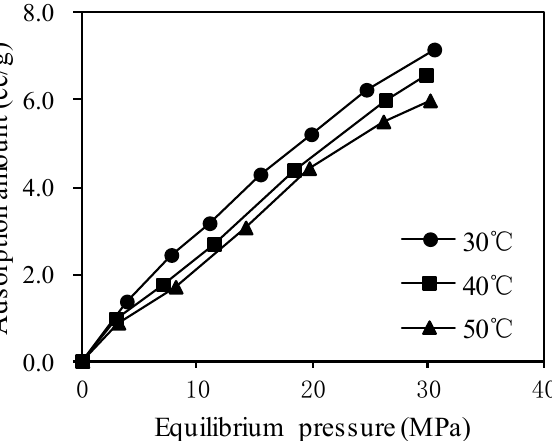
Figure 10. The relationship between adsorption rate constant and equilibrium pressure.